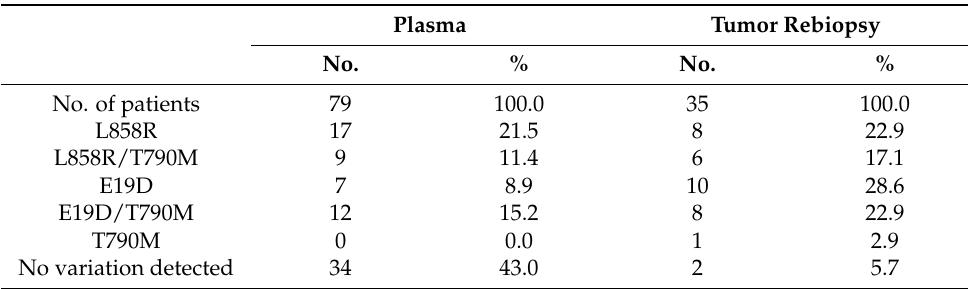
Table 4. EGFR mutation status determined from the plasma and tumor rebiopsy samples using the ddPCR platform at disease progression.